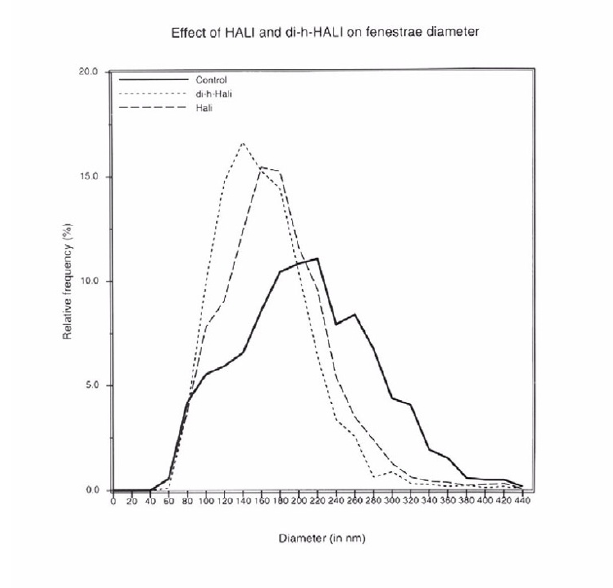
Figure 4 Diameter distribution of fenestrae, showing values for control, HALI, and di-h-HALI – treated LSECs, extending the data of fenestrae diameter of Table 1 . Table 1: Fenestrae diameter (nm) after treatment with HALI or di-h-HALI obtained by scanning electron microscopy Fenestrae diameter (nm) ± S.D. ± S.E.M. Control 212 di-h-HALI 165 * 1.3